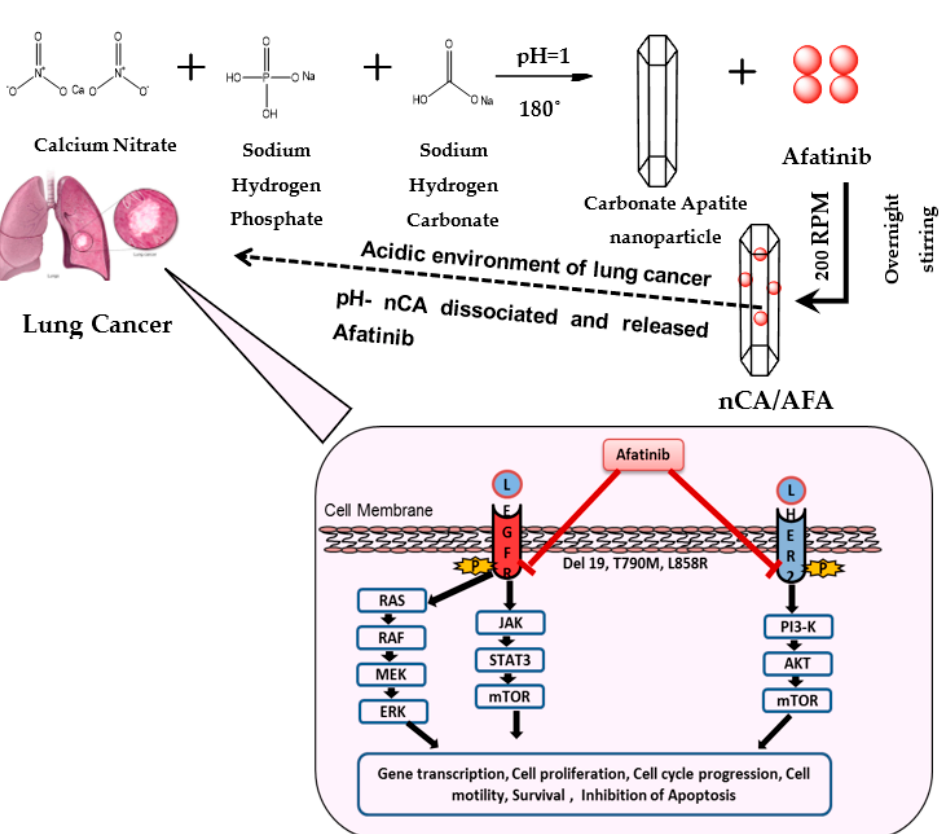
Figure 1. Schematic illustration of nCA/AFA nanocomposite synthesis and mechanism of action for targeted cancer cells. nCA/AFA nanocomposites are relatively stable at physiological pH, but they are dissociated in the acidic pH of cancer cells and the release of the afatinib drug. Afatinib is covalently bound to the ATP-binding site of the tyrosine kinase of EGFR, irreversibly inhibiting its autophosphorylation and leading to downregulation of the signalling pathways. As a result, it induces apoptosis and reduces cancer cell survival and proliferation.